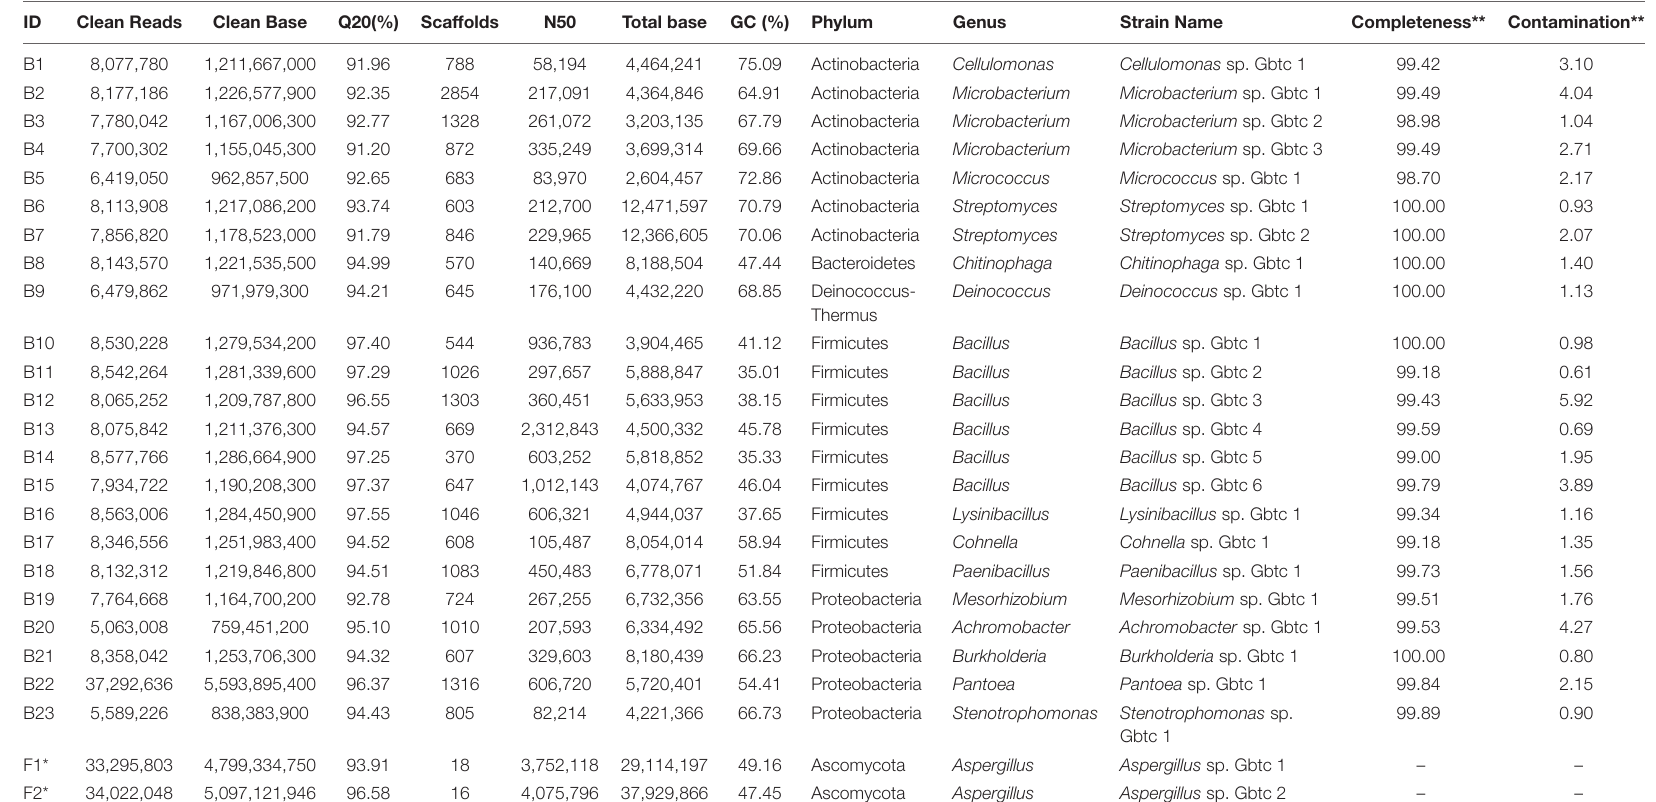
TABLE 1 | Species classification and draft genomes